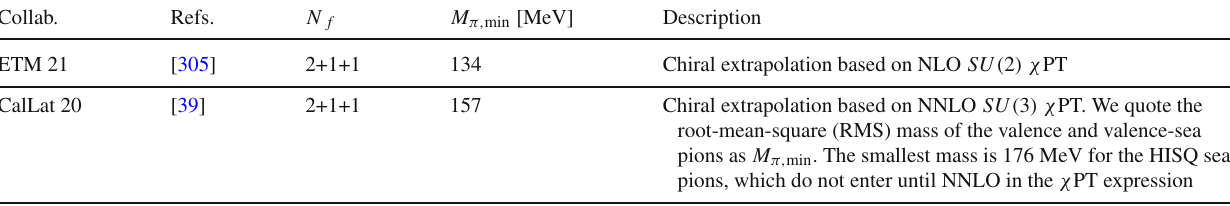
pions, which do not enter until NNLO in the χ PT expression